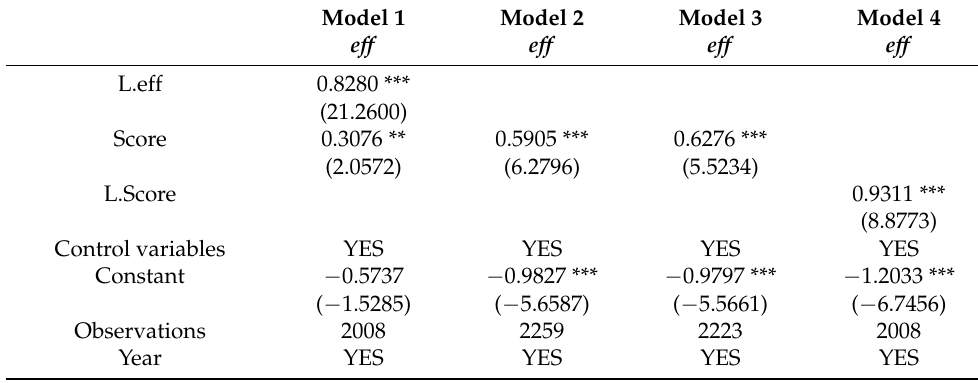
Table 5. Robustness test